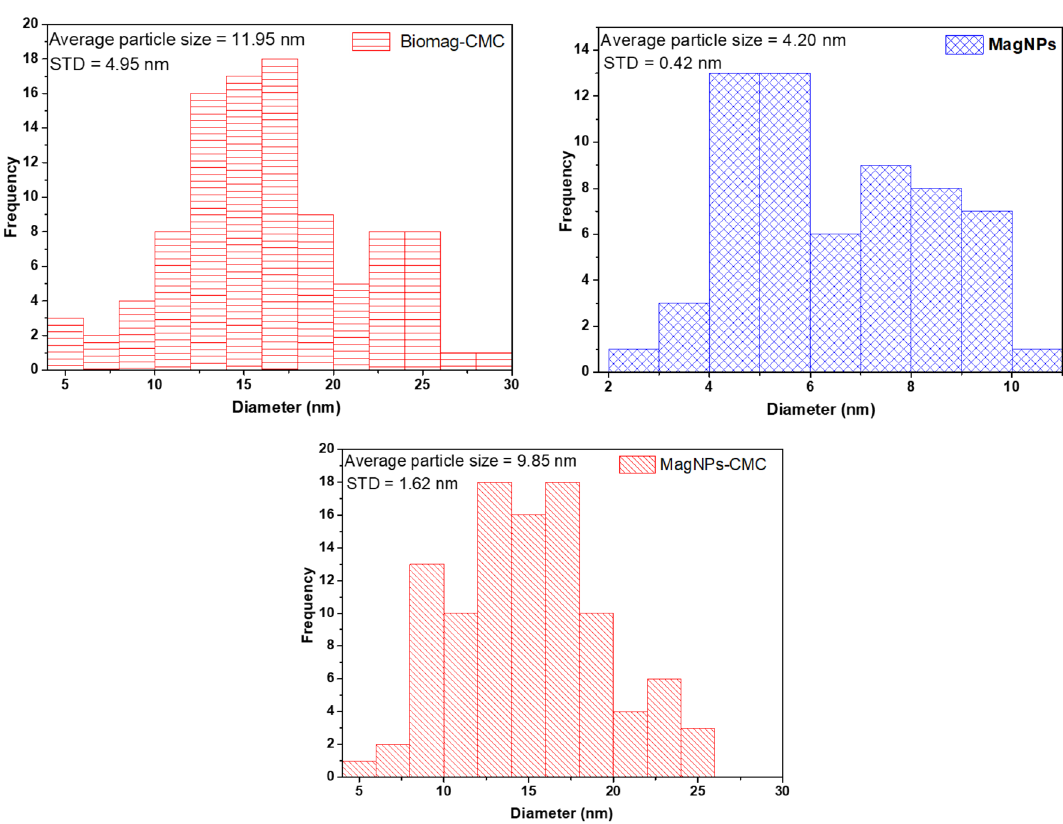
Figure 4. The estimated average particle size of BioMag-CMC, MagNPs and MagNPs-CMC using